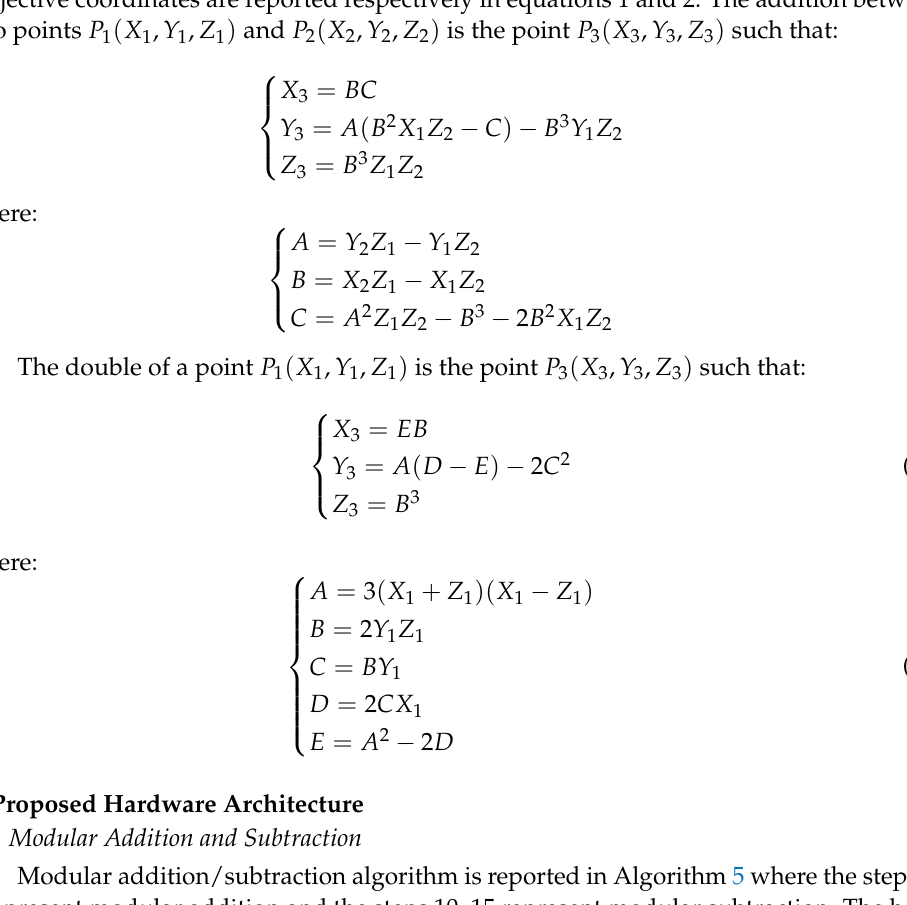
Table 1. Computational Cost of PA and PD. Affine Standard Projectives Jacobian Projectives PA 3M + 1I 14M 16M PD 4M + 1I 10M